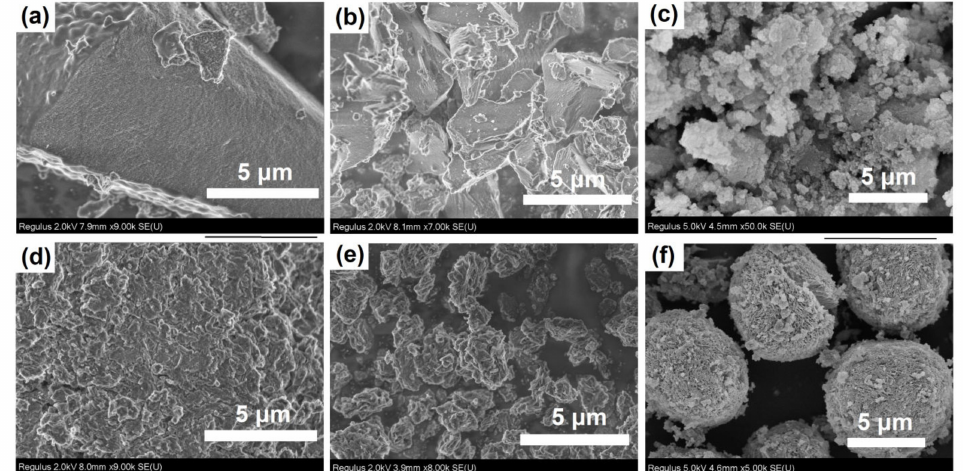
Figure 6. SEM image of silicoaluminophosphate gels: ( a ) Sample SAPO-PB-1.0; ( b ) Sample-SAPO- PB-1.5; ( c ) Sample-SAPO-iAl-1.0; ( d ) Sample-SAPO-iAl-1.5; ( e ) Sample-SAPO-PB-1.0(90); ( f ) Sample- SAPO-PB-1.0(120).